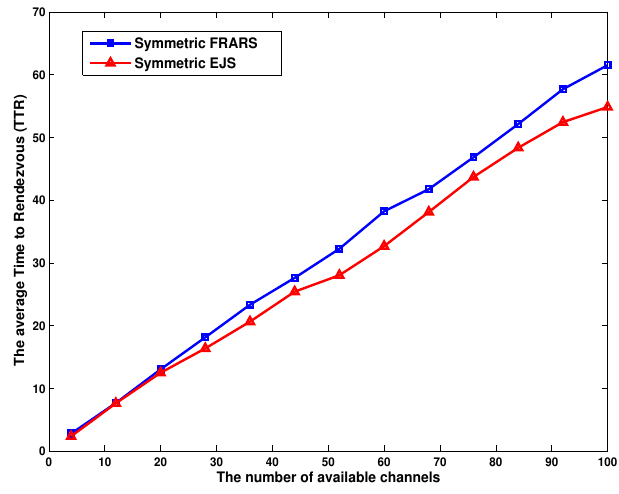
Figure 6. The average Time To Rendezvous (TTR) results for the symmetric FRARS and EJS schemes with M = [ 4, · · · ,100 ]